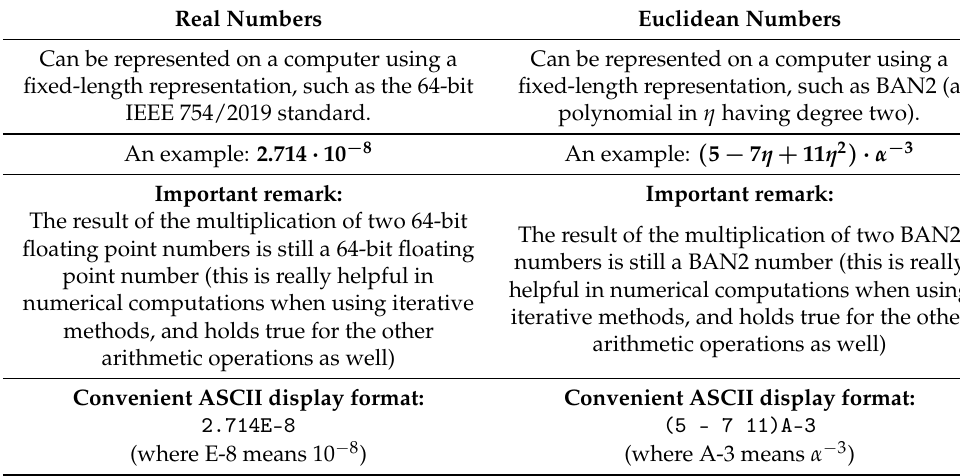
Table 1. Real Numbers vs. Euclidean